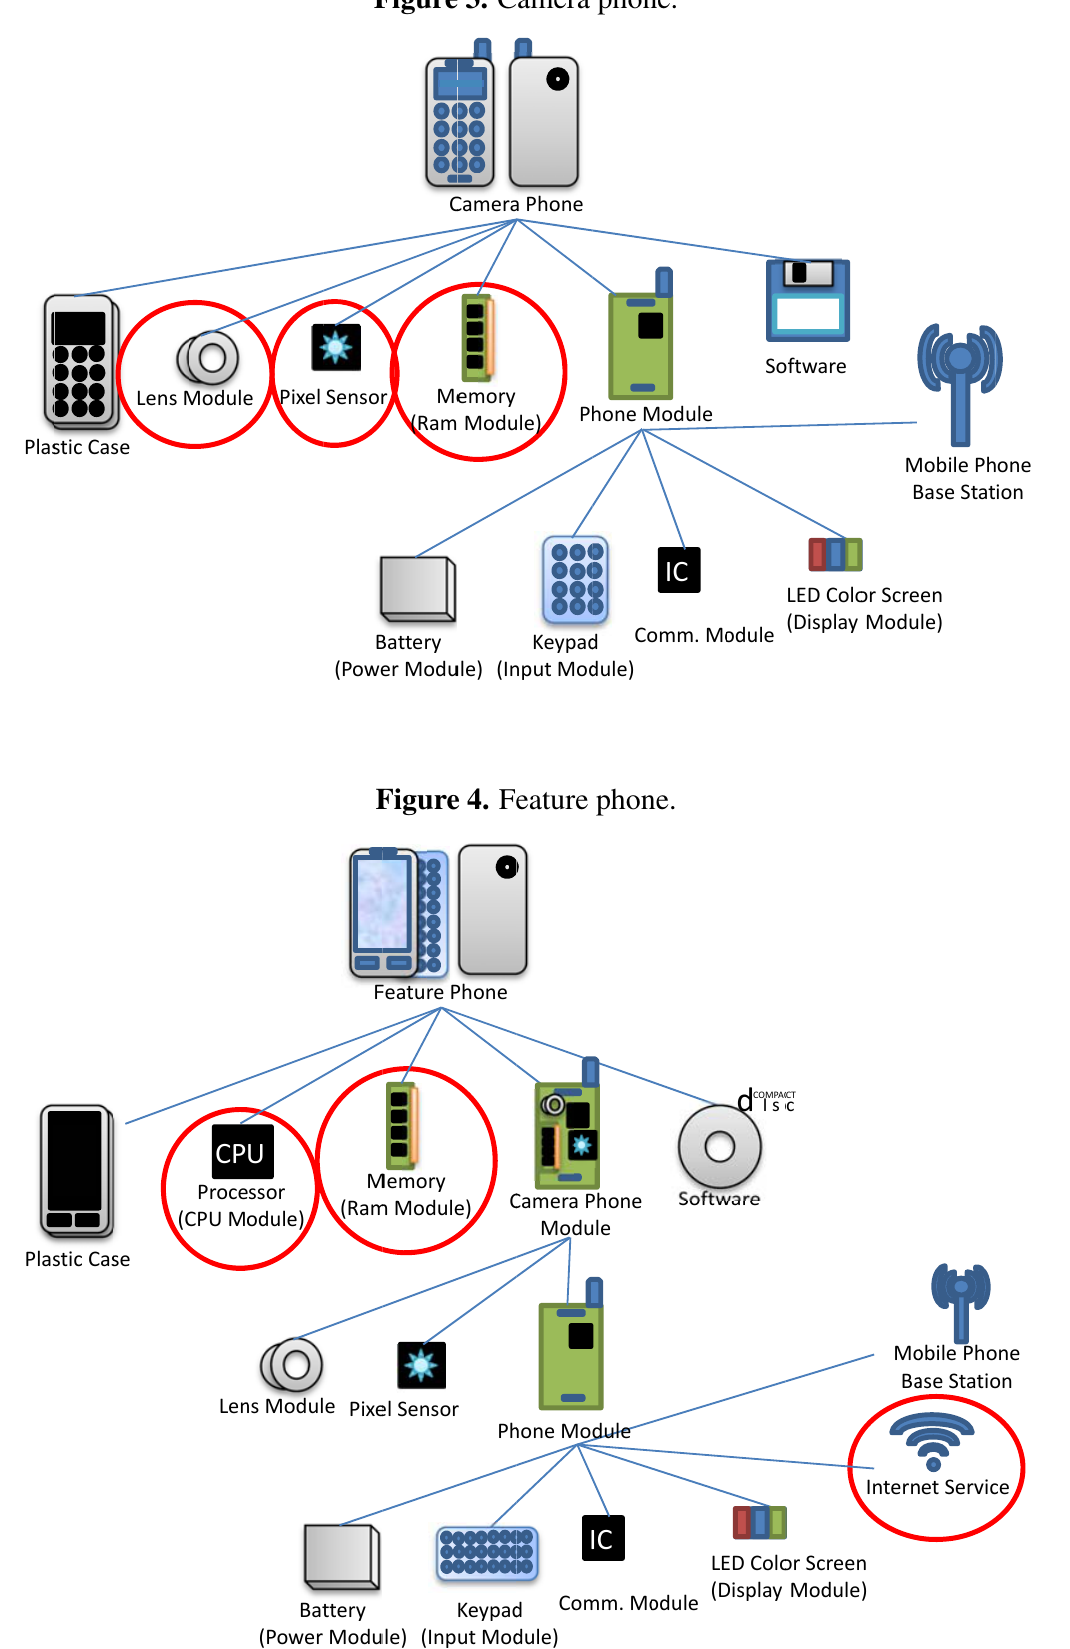
Figure 3. Camera phone.